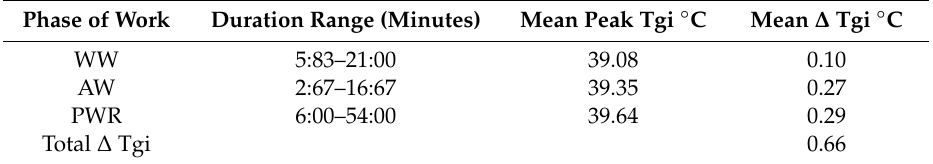
Figure 5. Mean gastrointestinal temperature (Tgi) (±SE) for human remains detection dogs during post-work recovery in handler vehicles. Table 3. Mean duration, peak gastrointestinal (GI) temperature (Tgi) and change in Tgi (Tgi) of each phase of